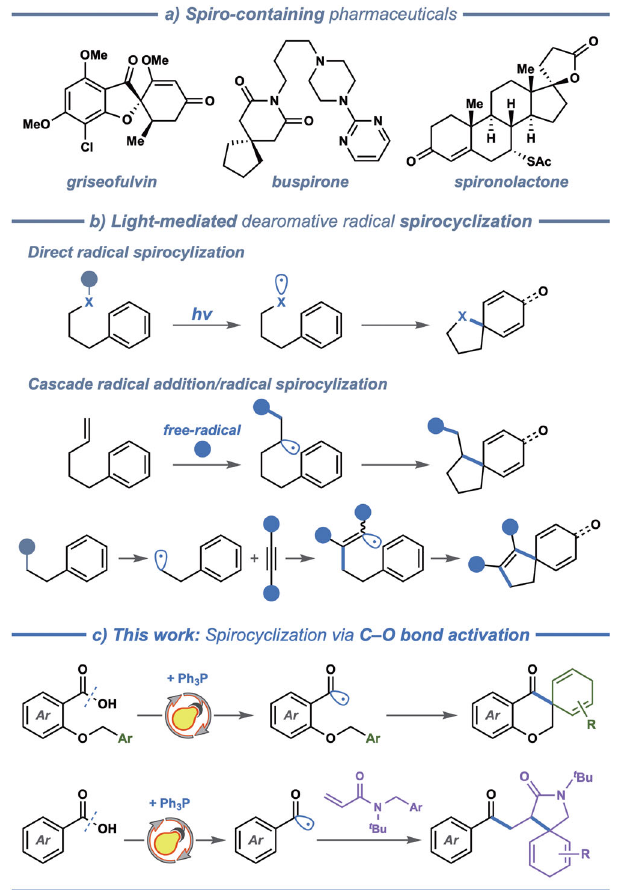
Fig. 1 Photocatalytic construction of spiro-compounds via radical dearomatization. a Examples of spiro-containing pharmaceuticals. b Different strategies for light-mediated dearomative radical spirocyclization. c This work: spirocyclization via C – O bond activation of carboxylic